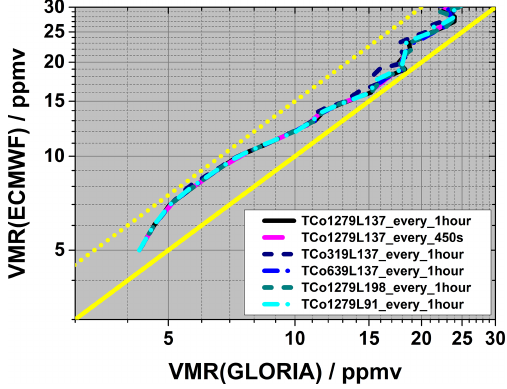
Figure 4. Low sensitivity of mean correlations between IFS sen- sitivity forecasts and GLORIA observations during the flight on 26 February 2016. IFS sensitivity forecasts include more frequent temporal output [450s (magenta) instead of 1h (black)], lower or higher horizontal resolution ( T Co 319 (dark blue), T Co 639 (blue), and T Co 1279 (black) all on cubic octahedral grid, instead of the operational T L 1279 on the linear grid) and higher or lower verti- cal resolution [L198 (dark cyan) and L91 (cyan) instead of L137